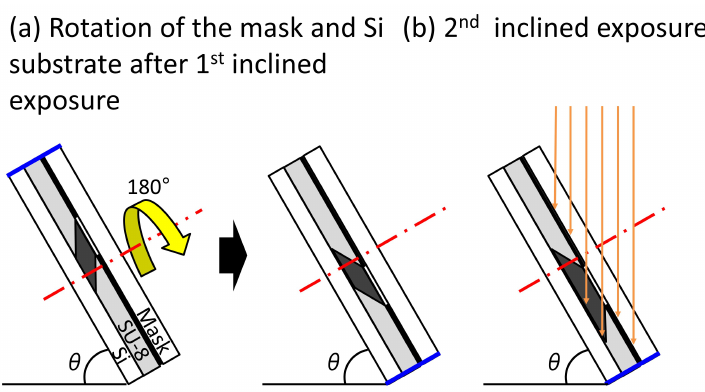
Figure 4. Schematic illustration of the exposure process for making a trapezoid-shaped cross- section mold. ( a ) Rotation of the mask and Si substrate after first inclined exposure; ( b ) second inclined